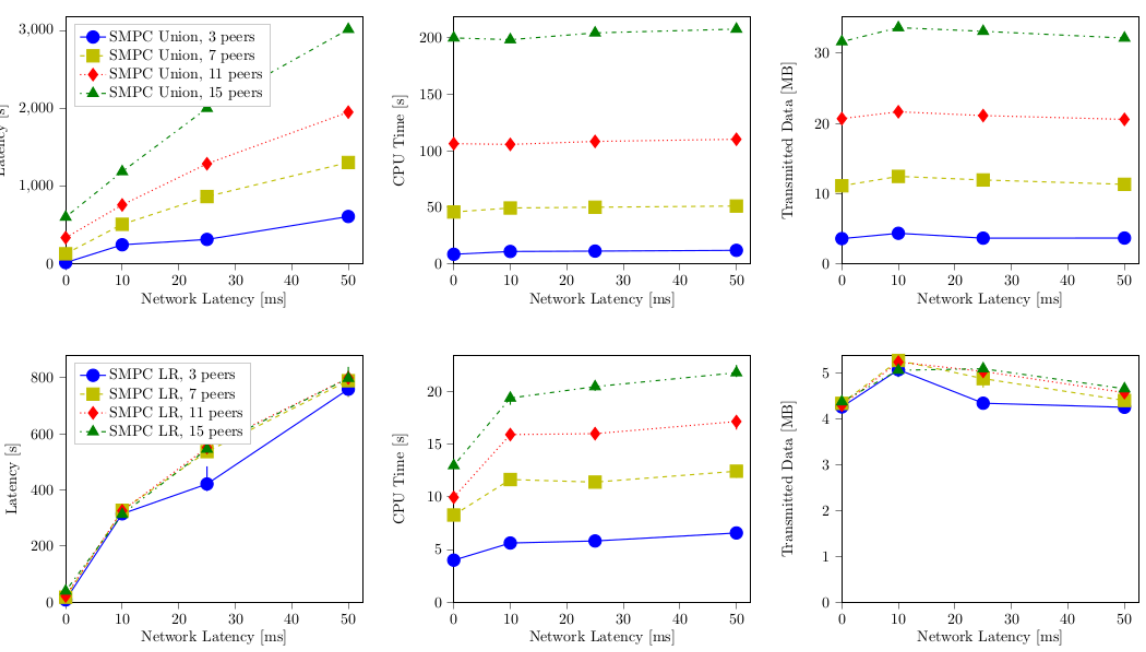
Figure 5. Influences of network latency manipulation. The upper row shows the union algorithm, the lower row shows the log-rank (LR) algorithm. It is clear that the network latency influenced the overall execution time while changing neither the central processing unit (CPU) time nor the number of packets transmitted. SMPC: secure multiparty